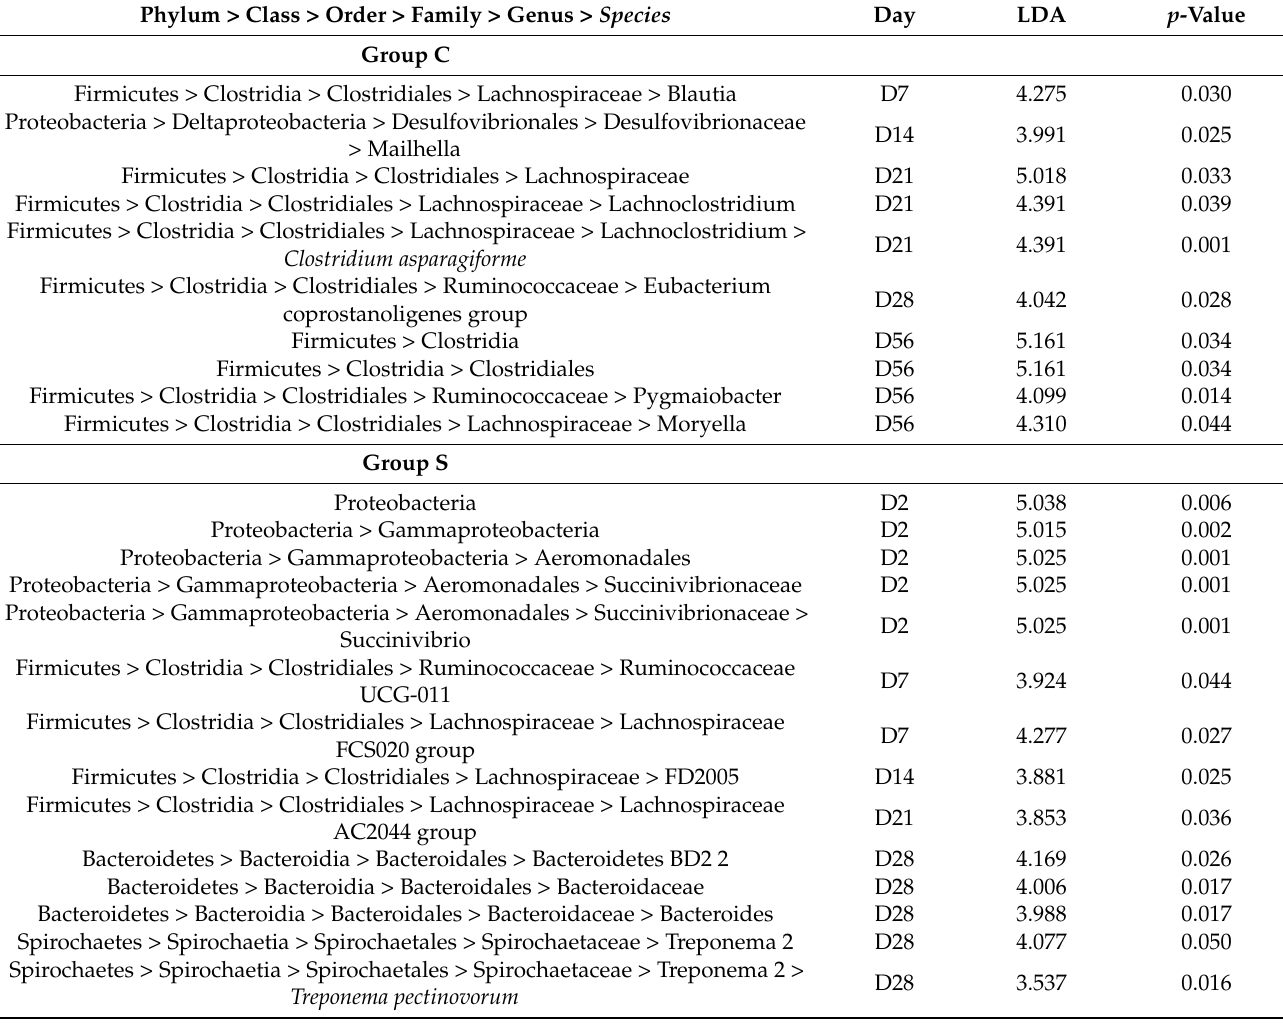
Table 2. Linear discriminant analysis size effect (LEfSe) showing significant taxa modifications in the fecal microbiome of horses from control (C) and supplemented (S)